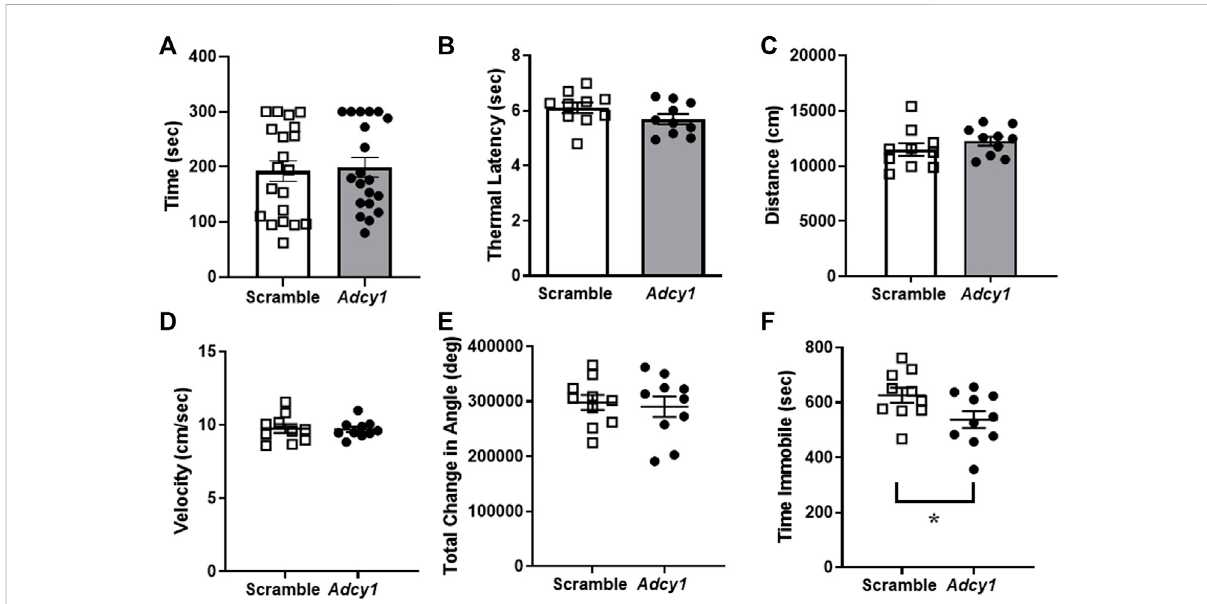
FIGURE 6 Animal mobility, thermal sensitivity and open fi eld behaviors are not affected in mice with intrathecal knockdown of Adcy1 . Mice underwent behavioral assessments to gauge mobility and the presence of behavioral de fi cits after intrathecal injection of AAV9-GFP-U6-m- Adcy1 -shRNA ( C ) or AAV9-GFP-U6-scramble-shRNA ( □ ) intrathecal injections. The (A) maximum time spent on a rotating rod, (B) thermal paw withdrawal latency, open fi eld assessments including the (C) distance traveled, (D) velocity, and (E) total change in angular orientation were not signi fi cantly different between treatment groups. (F) The time spent immobile in seconds was signi fi cantly decreased in AAV9- Adcy1 compared to AAV9- scramble mice (unpaired t -test, p = 0.0433), n = 10/group.